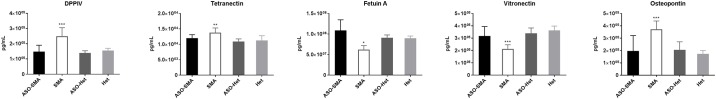
SMN-Responsive analytes.Levels of biomarker analytes were compared at P12 in ASO-SMA mice (n = 12), in SMA mice (n = 13), ASO-Het (n = 10), and Het mice (n = 5). ASO-Het mice were considered controls for statistical comparison using One-way ANOVA and Dunnett's multiple comparisons test (GraphPad Prism, La Jolla CA). Statistical differences between cohorts and controls are shown as * <0.05, ** <0.01, *** <0.001.